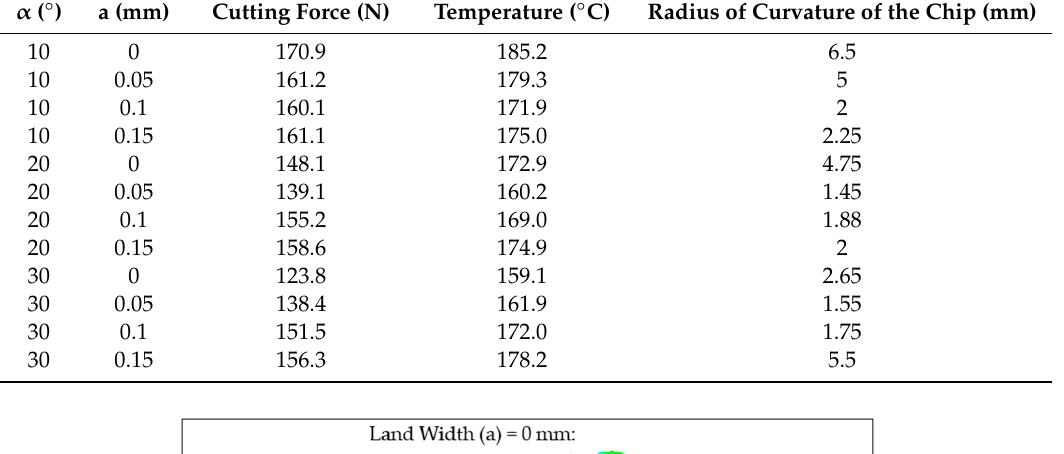
Table 2. Results of the simulation for rake angle ( α ) and land width (a).